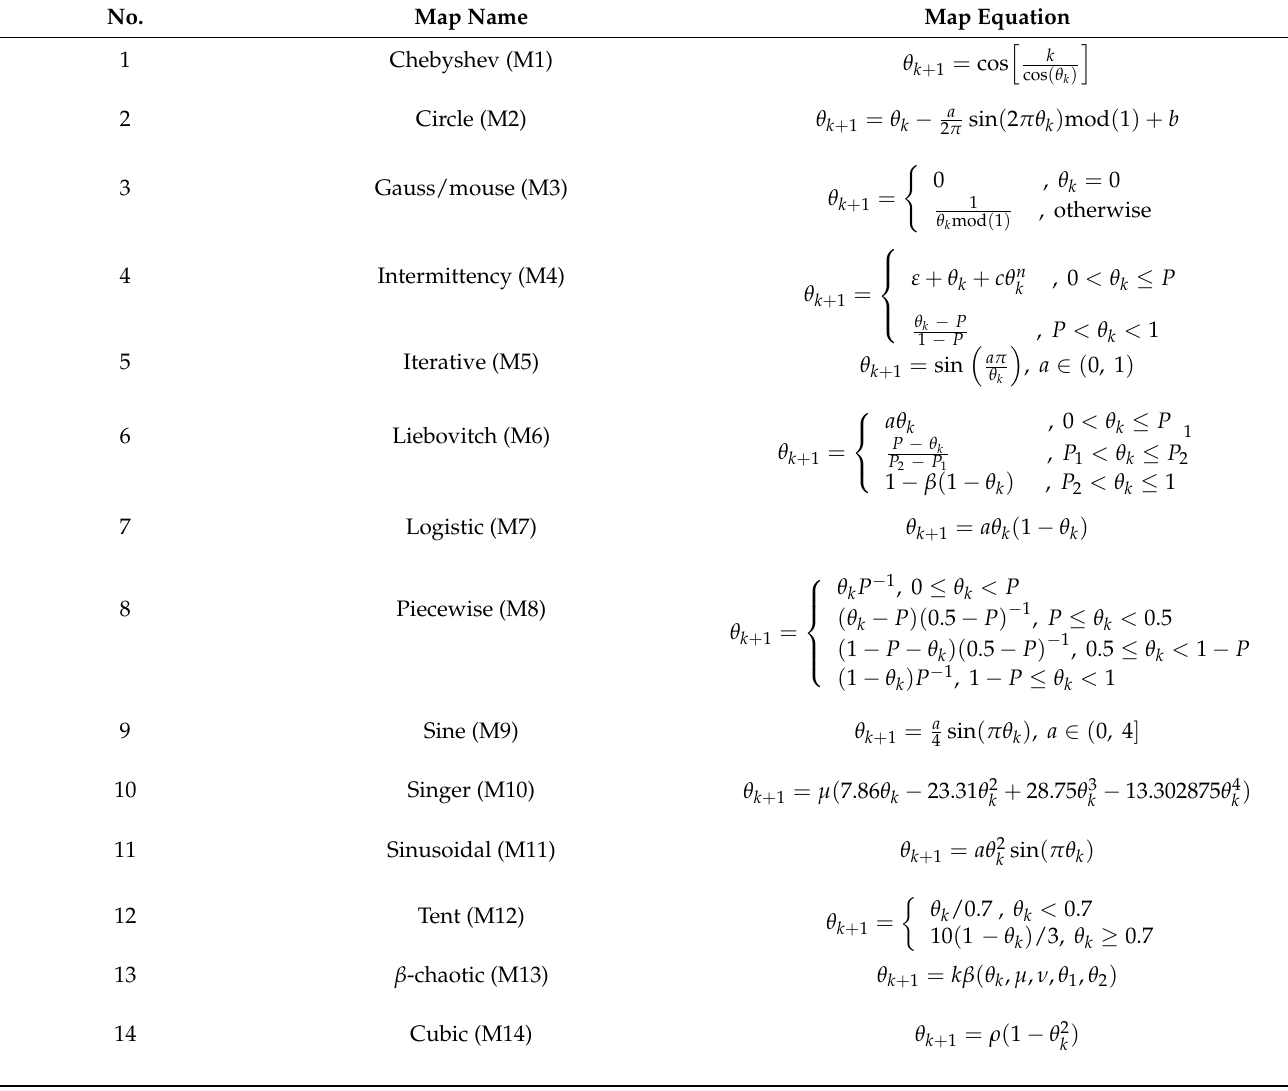
Table 1. Fourteen chaotic